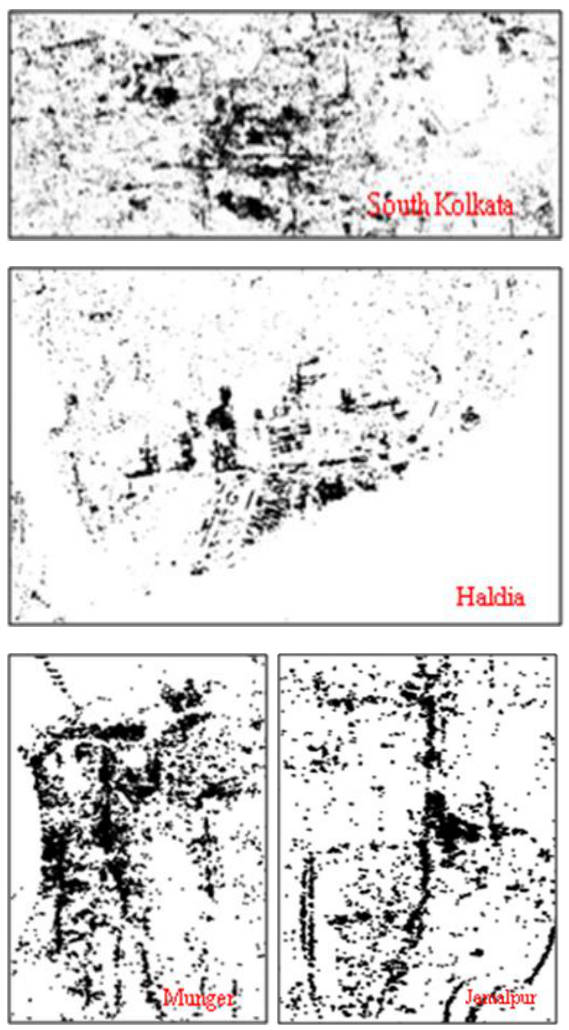
Figure 3. Classified binary images from the SAR-based indexed maps distinguishing built-up (in black) from non built- up (white) areas.